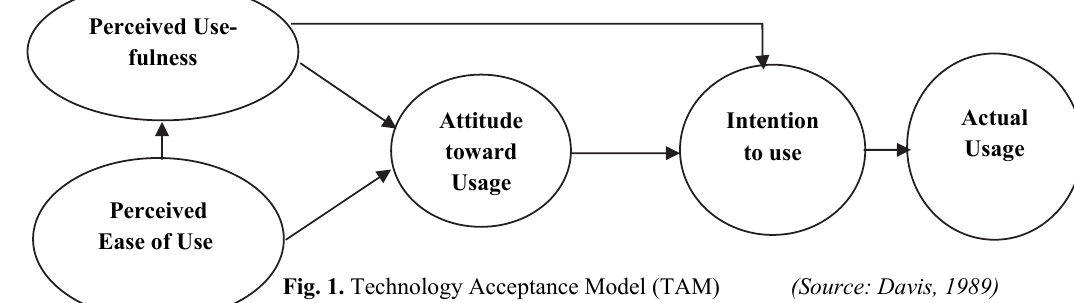
Fig. 1. Technology Acceptance Model (TAM) (Source: Davis,